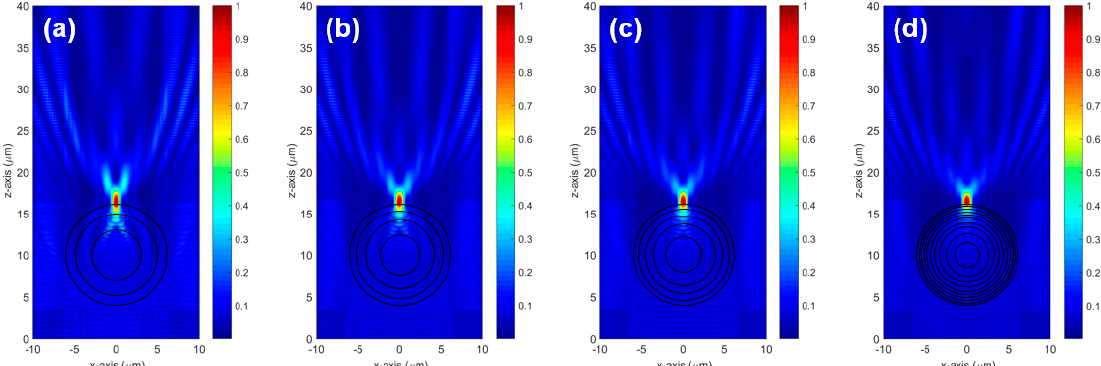
Figure 4. Simulated intensity distributions of Luneburg lenses with the EIS index profile: ( a ) N = 3, ( b ) 4, ( c ) 5 and ( d ) 10, respectively. Larger N s (>6) show almost the same response as the Luneburg lens with a continuous GRIN profile. The intensities are normalized. Concentric circles depict the step boundary of the index profile in ( a ). Here, the smallest step number for the optimal performance ( N opt ) is determined to be 4.